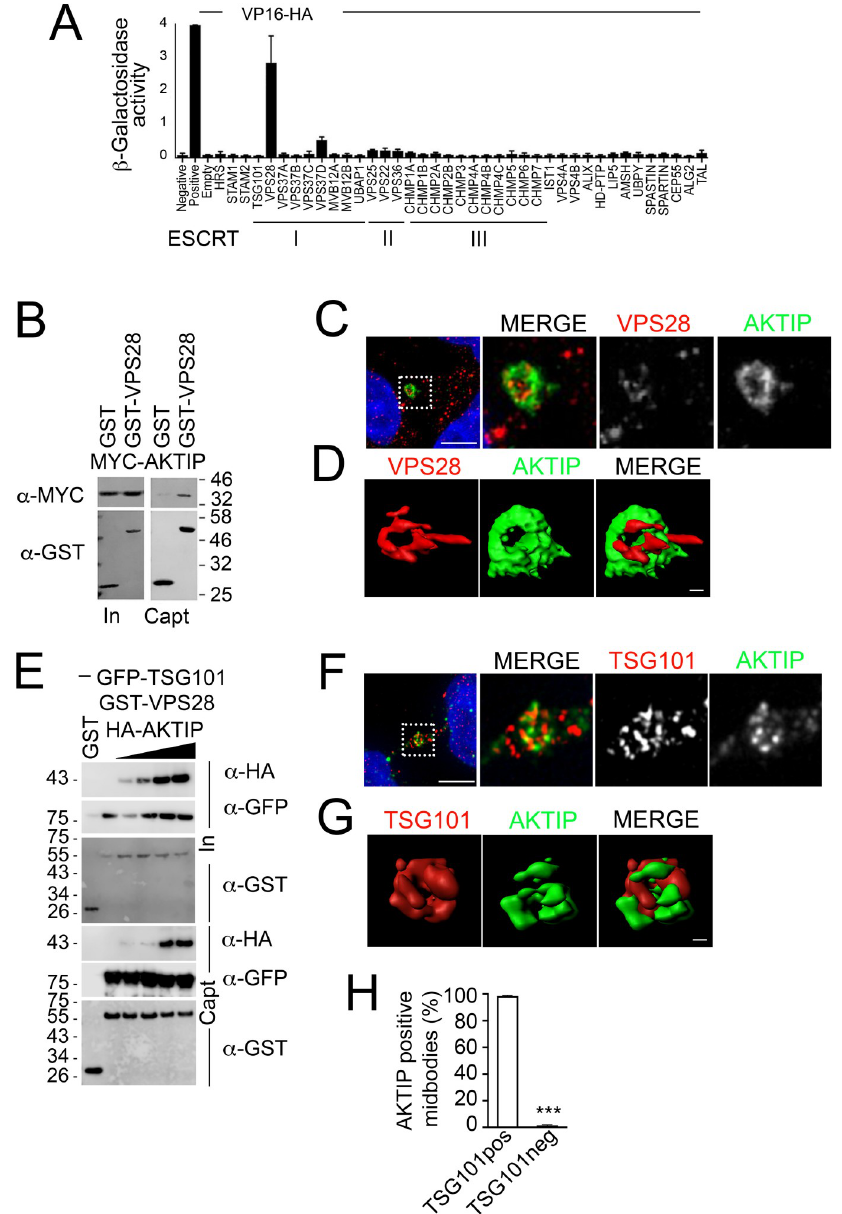
Fig 2. AKTIP is associated with the ESCRT I subunits VPS28 and TSG101. (A) AKTIP fused to the Gal4 DNA binding domain was tested for interactions with the human components of ESCRT I, II, III, and ESCRT associated proteins fused to the VP16 activation domain by yeast two-hybrid assay. Error bars indicate the SEM from the mean of triplicate measurements. (B) Western blotting showing that AKTIP interacts with GST-VPS28 but not with GST alone. Cells were transfected with plasmids encoding the indicated fusion proteins. Purified VPS28-GST or GST alone were used to pull down interacting proteins; cell lysates and glutathione-bound fractions were then analyzed with MYC antisera. GST-pull down was repeated three times. (C) Spinning disk microscopy images of AKTIP (green) and VPS28 (red). Scale bar, 5 μ m. (D) 3D rendering of spinning disk imaging as in (C) showing that AKTIP and VPS28 are in proximity at midbody. VPS28 in late midbodies displays also an asymmetric protruding element. Scale bar, 0.5 μ m. (E) Western blotting showing that HA-AKTIP, GFP-TSG101 and GST-VPS28 are captured together in GST pull down experiment. Cells were co-transfected with a fixed amount of plasmid encoding GFP-TSG101 (500 ng) and GST-VPS28 (1000 ng) and increasing amounts of HA-AKTIP (0, 50, 100, 500 or 1000 ng) encoding plasmid. Cell lysates and GST pull down fractions were then analyzed with GST, GFP, HA antisera. GST-pull down was repeated three times. (F) Spinning disk microscopy images of AKTIP (green) and TSG101 (red). Scale bar, 5 μ m. (G) 3D rendering of spinning disk imaging as in (E) showing that AKTIP and TSG101 are near each other. Scale bar, 0.5 μ